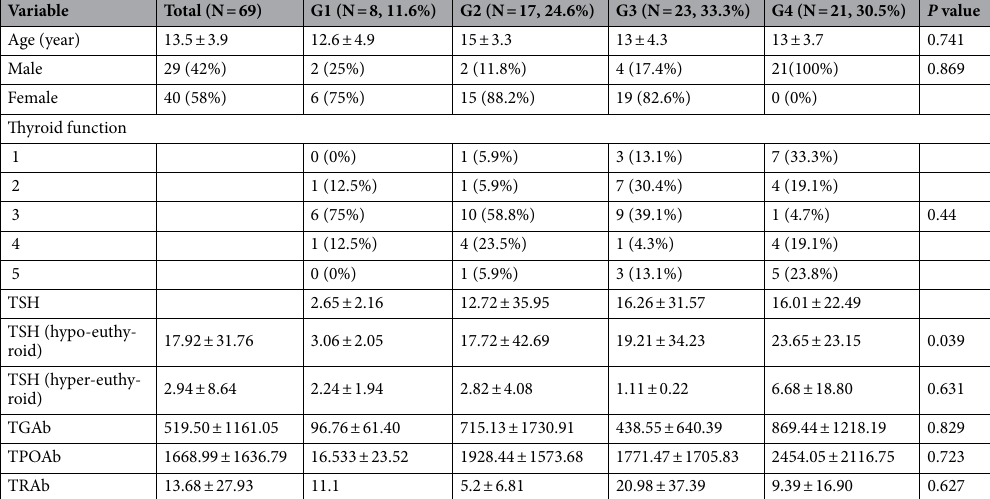
Table 2. Clinical characteristics according to ultrasound grade in HT patients. G, grade; N, number of patients; TSH, thyroid stimulating hormone; TG, antithyroglobulin antibodies; TPO, antithyroid peroxidase antibodies; TRAb, TSH receptor